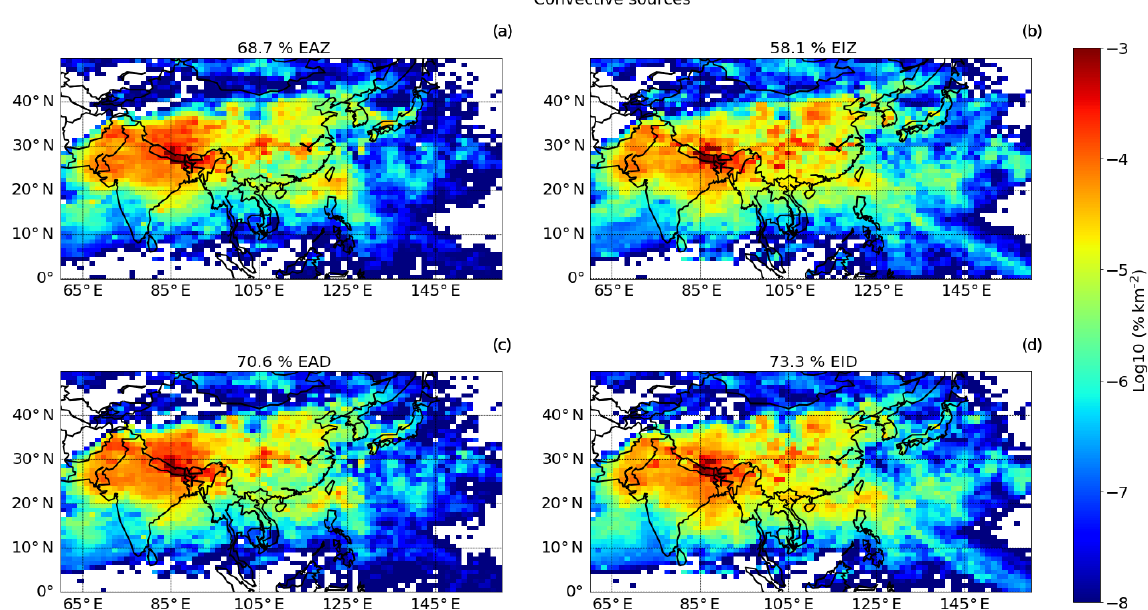
Figure 4. Convective-source distribution identified by the trajectories for the whole aircraft campaign. The probability per square kilometre of finding a source over a specific area is computed as the fraction of parcels that encounter a convective cloud there with respect to the total number of released parcels. The plots are in logarithmic scale. The percentage in the title indicates the fraction of convective parcels integrated over the whole surface. (a) Convective-source distribution obtained with ERA5 meteorology and kinematic vertical motion (EAZ); (b) ERA-Interim meteorology and kinematic vertical motion (EIZ); (c) ERA5 meteorology and diabatic vertical motion (EAD); (d) ERA- Interim meteorology and diabatic vertical motion